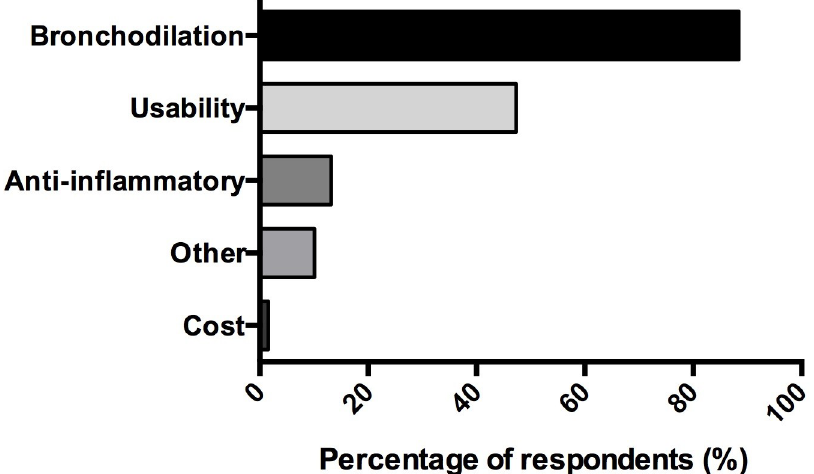
Fig 4. Properties of volatile anesthetics for inhaled intensive care unit sedation, as reported by respondents. (n = 129) Data are represented in % .